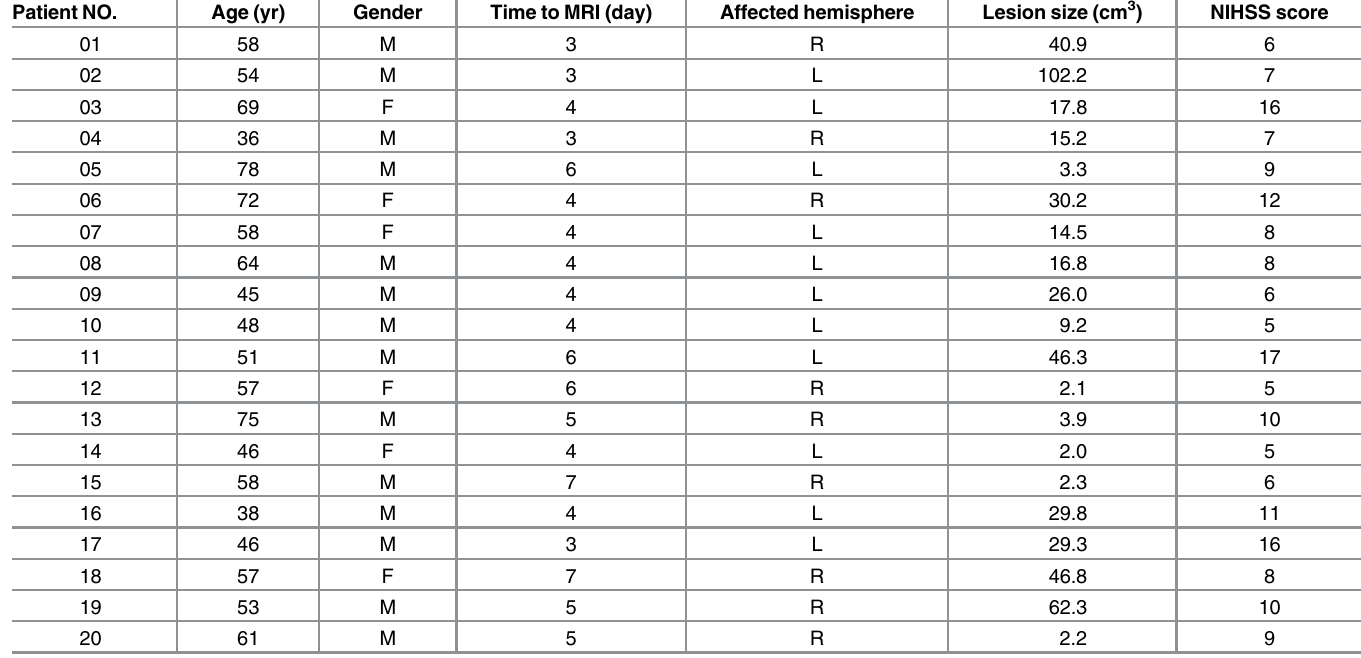
Table 1. The clinical characteristics of stroke